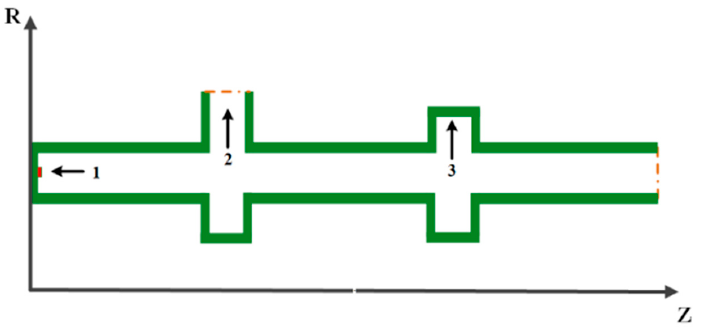
Figure 4. The modulation model of input and second bunching cavity: 1—cathode, 2—input cavity, 3—second bunching cavity.